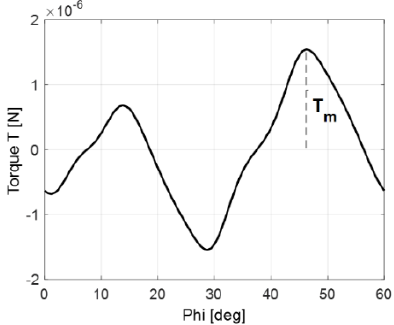
Figure 2. Torque versus rotation angle over 60°.